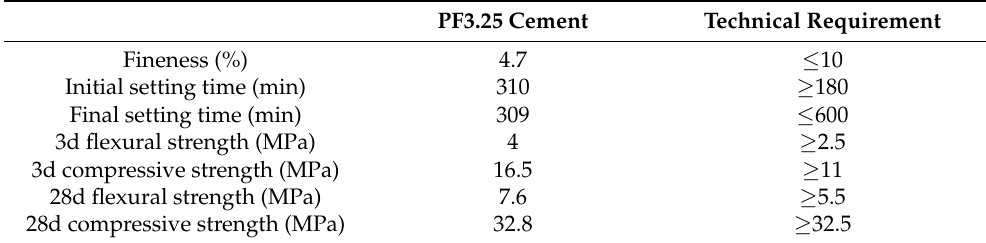
Table 7. Material properties of cement.